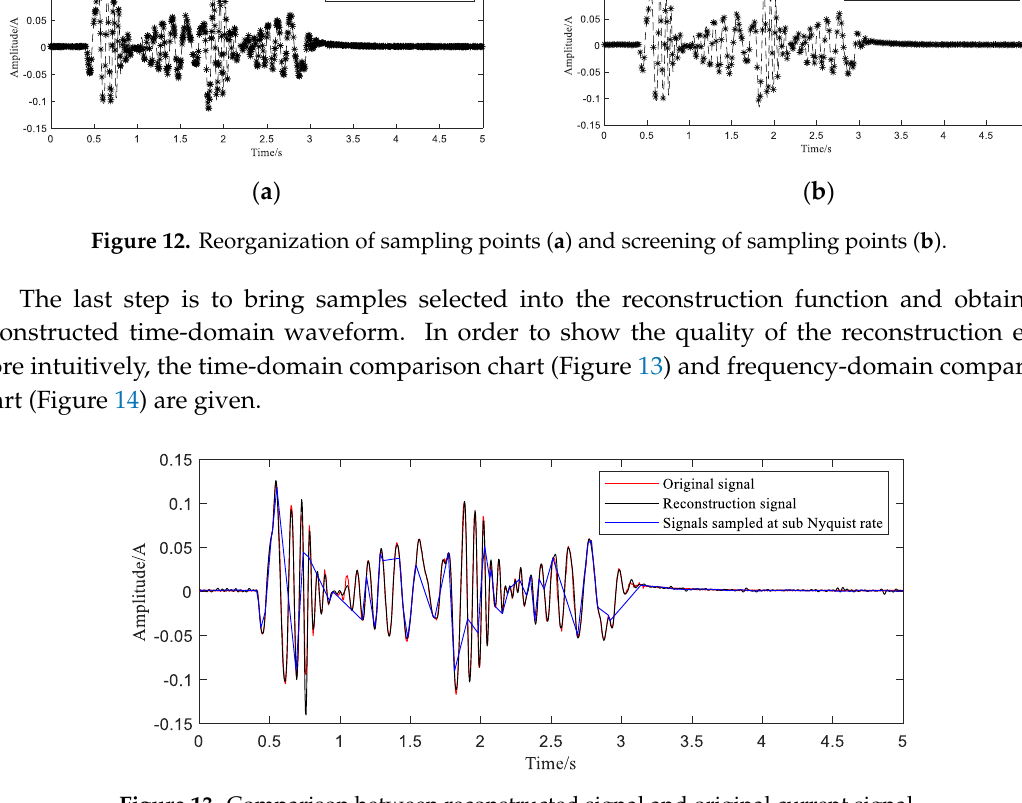
Figure 13. Comparison between reconstructed signal and original current signal.